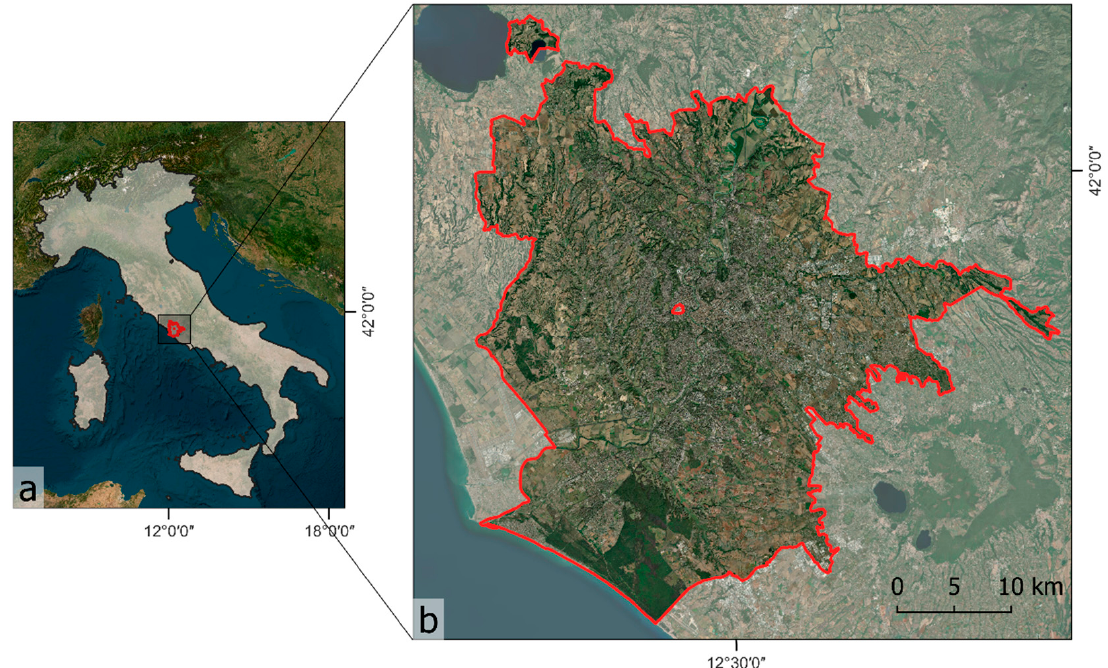
Figure 1. ( a ) Location of the study areas in Italy; ( b ) the Municipality of Rome. The municipality is located in the Tiber valley and is spread over an area of 1287 km². Rome is the largest municipality in Italy and is one of the largest European capitals, with a territory with a low population density due to the presence of numerous green urban